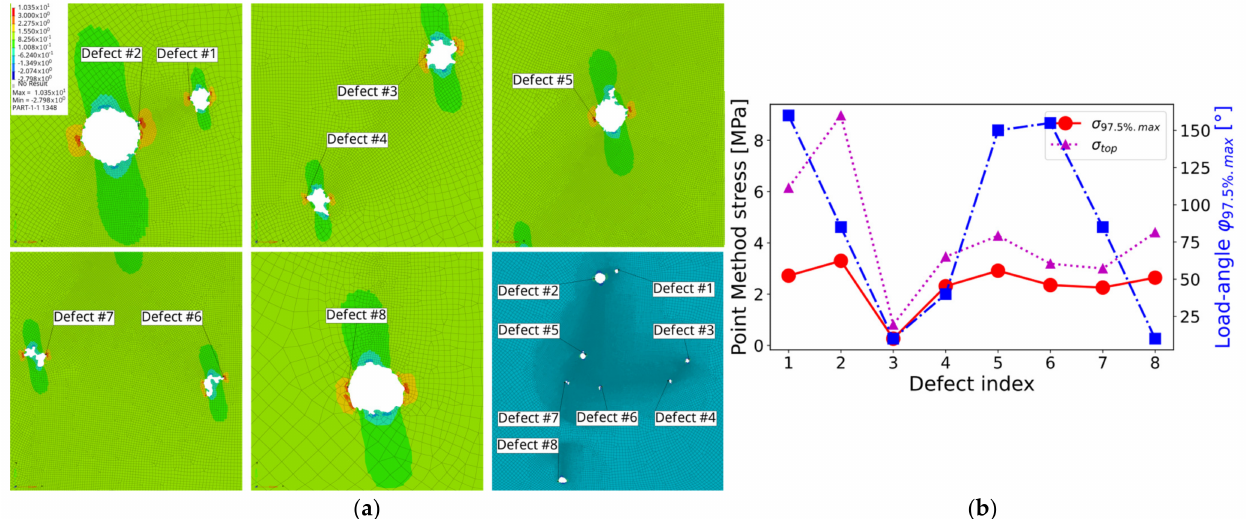
Figure 29. Example of TCD evaluation of pore network following ASTM Standard E446 classA1 applying the sub-case method (mesh ‘ASTM_A1_quad_v1’): ( a ) Contour plots for load angle ϕ = 100 ◦ ; and ( b ) Course of evaluated Point Method stress values and load angle per